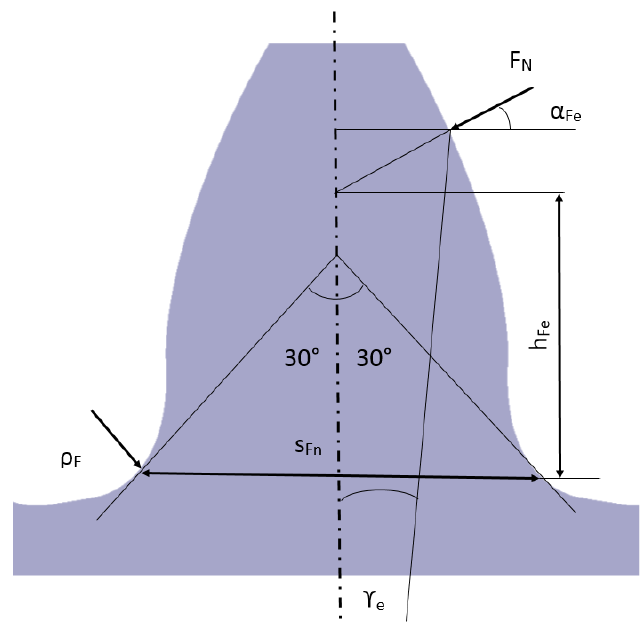
Figure A1. Model of DIN3990 Method B for stress calculation.